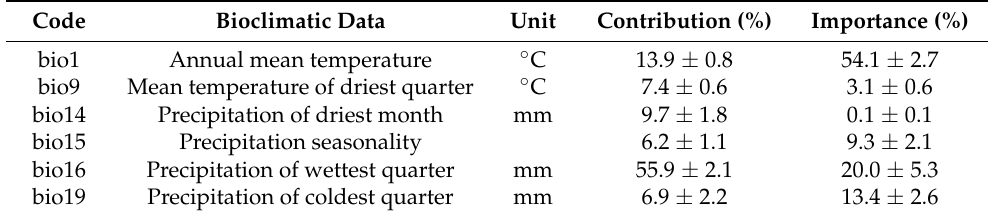
Table 1. Environmental variables used for MaxEnt